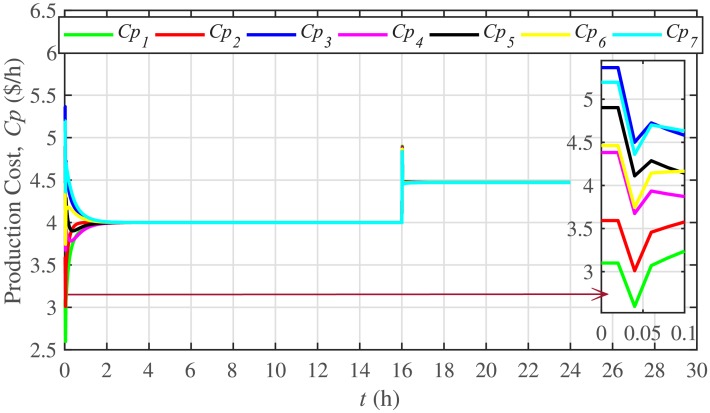
Production costs consensus under case 1.